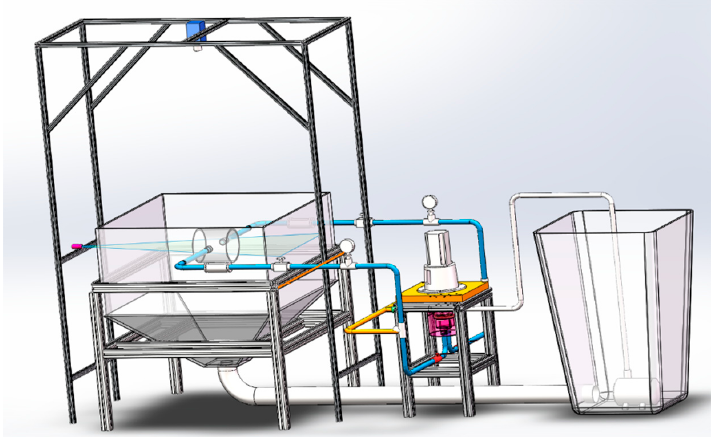
Figure 5. Part of the experimental system physical drawing.